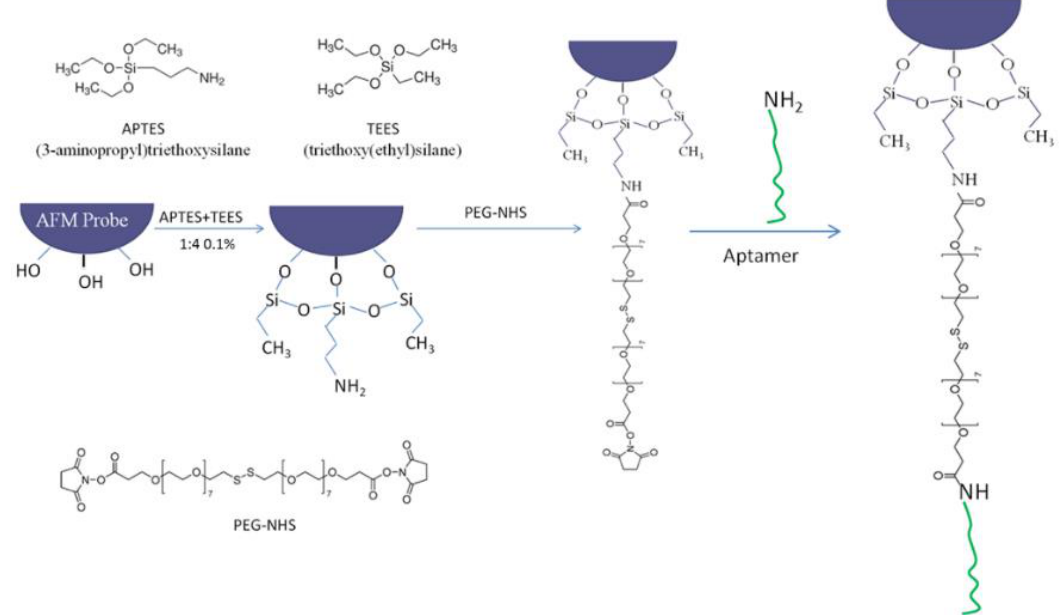
Figure 1. Modification of the AFM probes and conjugation of the ssDNA